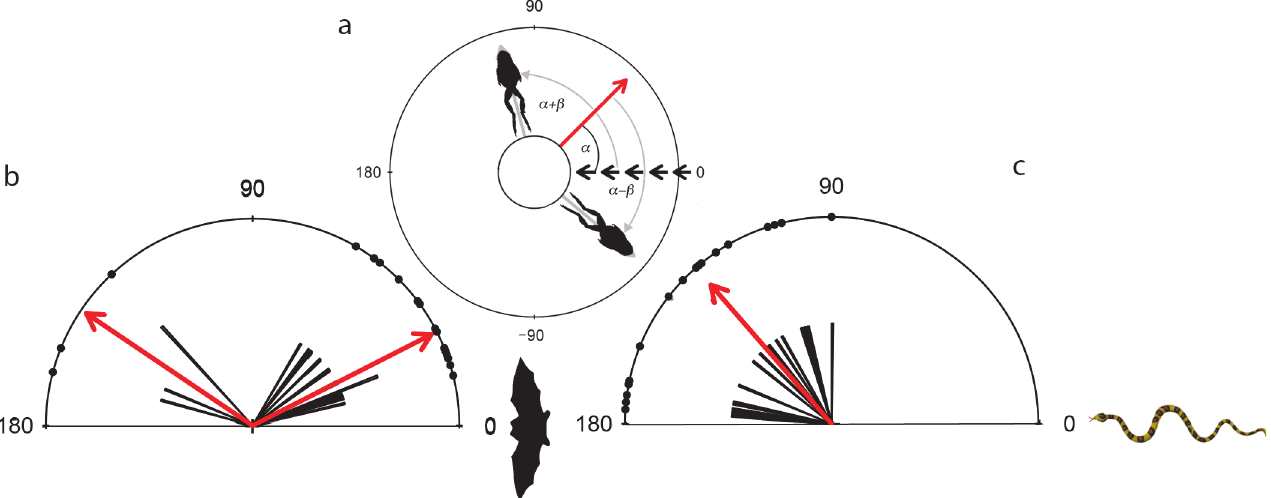
Fig 4. Randomness of escape trajectories of túngara frogs. (a) Schematic illustrates method of measuring the angle for fleeing frogs relative to the predator model; Short black arrows indicate trajectory of predator approach at 0°; Long arrow indicates prey orientation while angle α indicates the prey ’ s angle of deviation from the predator approach. Angles α + β and α - β are the resultant angles of flight relative to their initial orientation of the prey to the predator. Escapes to the left and right of the predator were pooled as if the escapes were always to the predator's right. (b) and (c) are pooled data for the bat and snake respectively with the arrow indicating the median resultant angle of